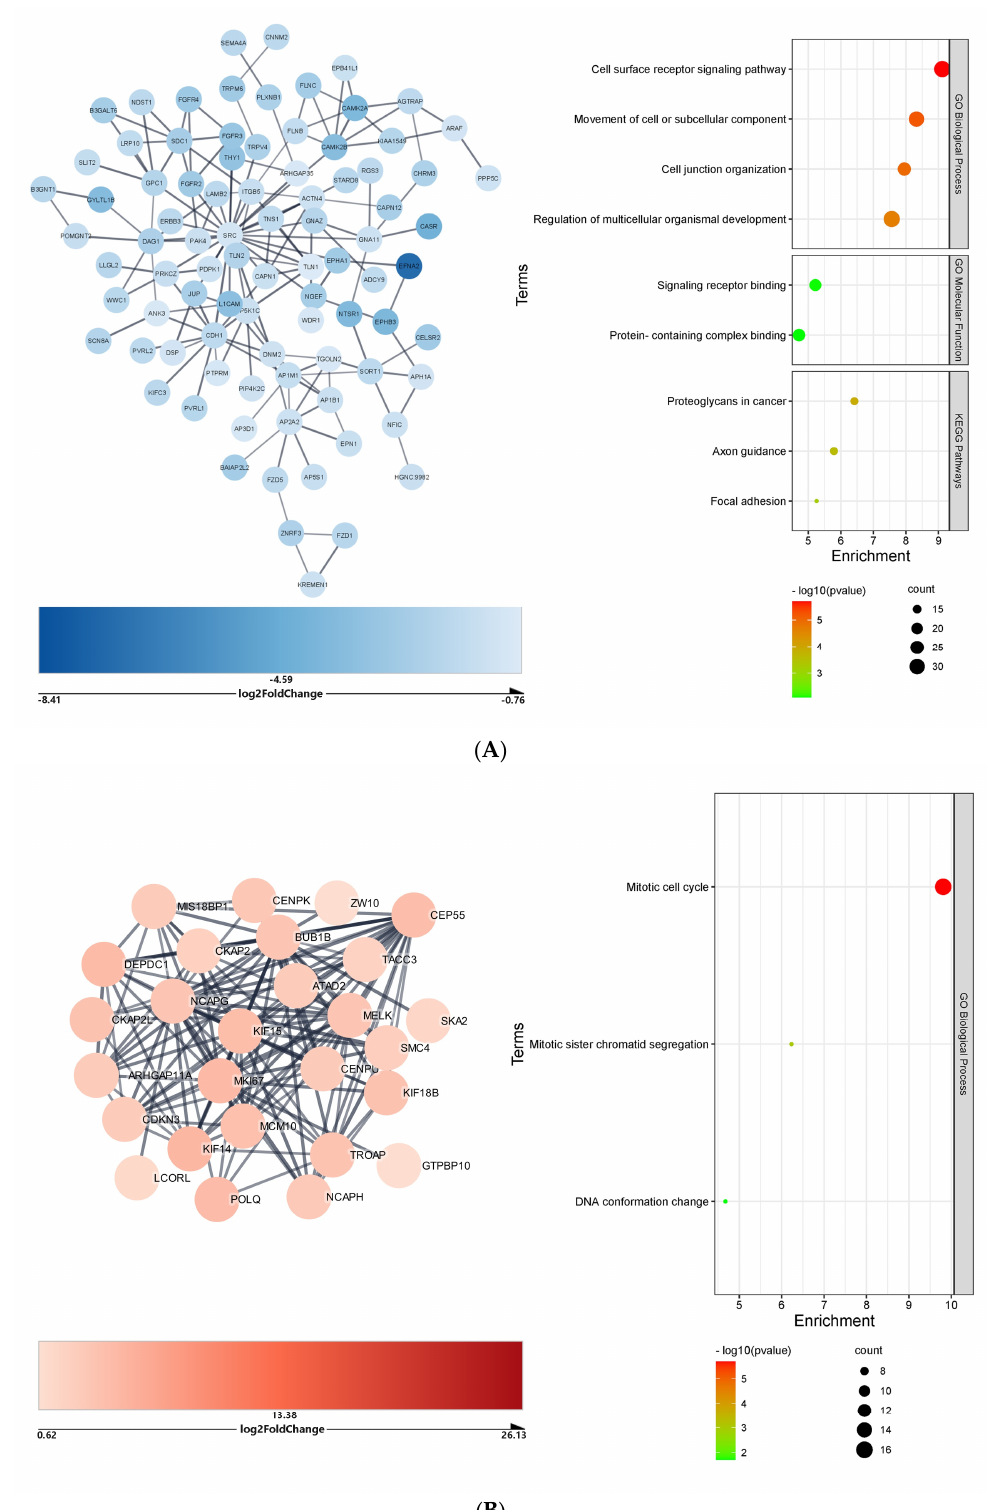
Figure 5. Cluster and functional enrichment analysis of COVID − 19 kidneys DEGs targeted by differentially expressed microRNAs: STRING interaction confidence score > 0.7; Markov clustering inflation value = 4; STRING Enrichment FDR < 0.05; redundancy score = 0.5. ( A ) Cluster and functional enrichment analysis of COVID-19 kidney downregulated DEGs targeted by upregulated microRNAs. ( B ) Cluster and functional enrichment analysis of COVID-19 kidney upregulated DEGs targeted by downregulated